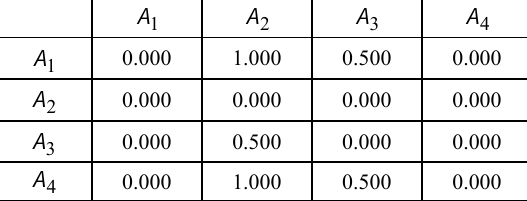
Table 15. Preference degree with respect to criterion